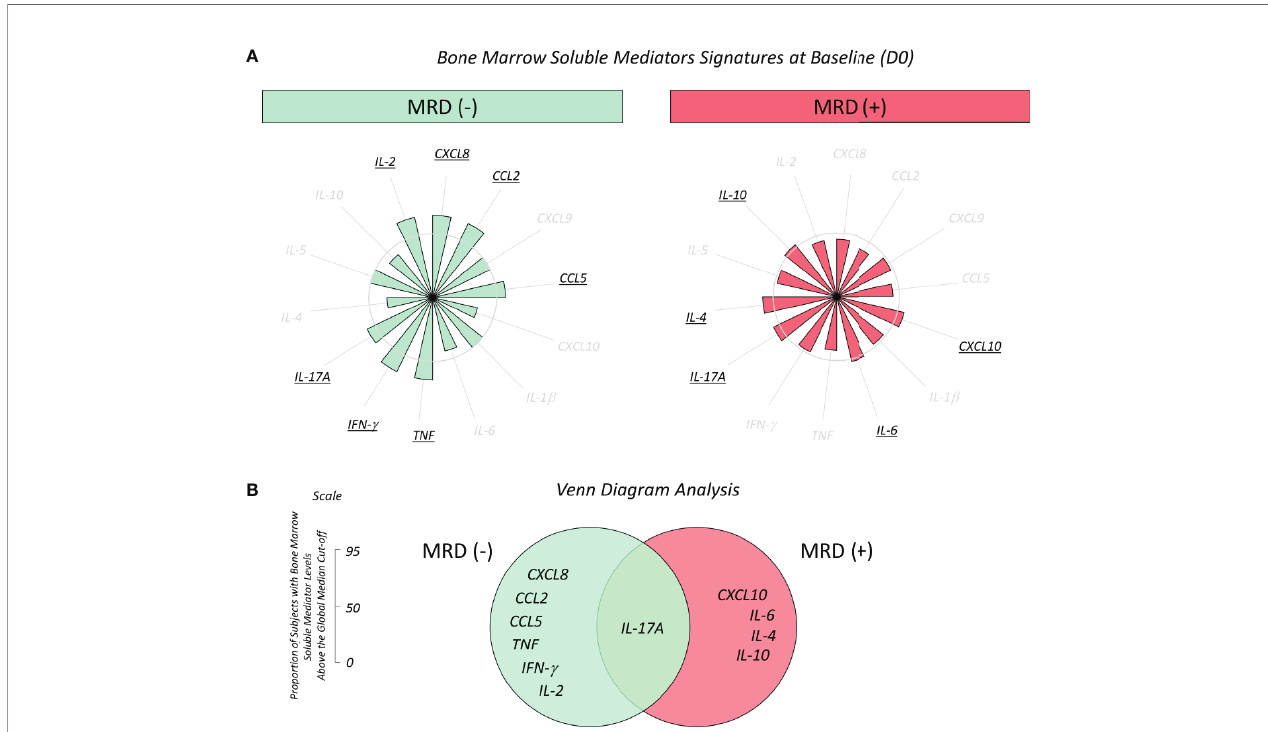
FIGURE 5 | Overall signature of bone marrow soluble mediators in B-ALL patients according to the minimal residual disease detection on D35. (A) Bone marrow soluble mediator signature at baseline (D0) in B-ALL patients categorized according to the minimal residual disease detection on D35 of induction therapy, denominated as MRD (-) ( ) and MRD (+) ( ) subgroups. Bone marrow soluble mediators were quanti fi ed by CBA and ELISA (IL-1 b and IL-5) assays as described in the Materials and Methods section. Data, originally expressed in MFI or pg/mL (IL-1 b and IL-5) were converted into categorical data using the global median values obtained for each biomarker as the cut-off to classify each patient since they presented low or high levels of immunological mediators in the bone marrow plasma. The biomarker signatures were assembled in radar charts using the 50 th percentile as the threshold (central circle) to identify biomarkers with increased levels in a higher proportion of patients, and then selected for further analysis. (B) Venn diagram analysis underscores common and selective biomarkers for each clinical subgroup with the potential to classify B-ALL patients according to the minimal residual disease detection on D35 of induction